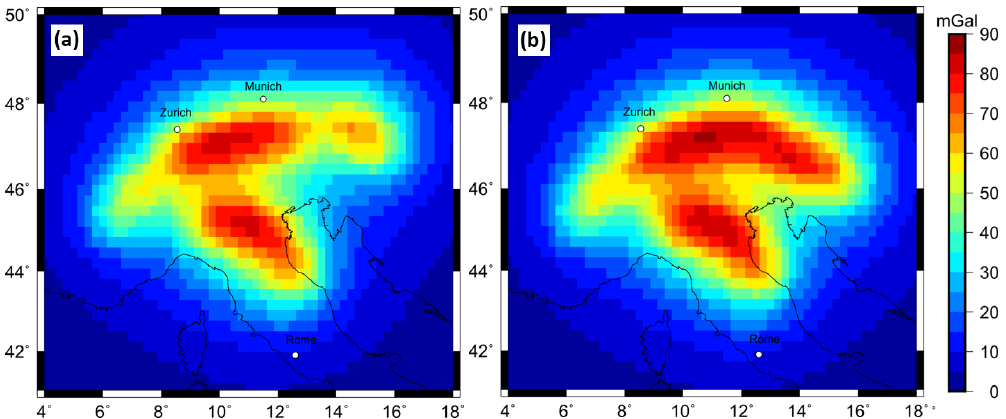
Figure 6. Forward-calculated gravity disturbance signal at a station height of 6040m for predefined subcrustal slab geometries with a content density contrast of 60kgm − 3 and a constant thickness of 80km. (a) Predefined slab Configuration 1. (b) Predefined slab Configuration